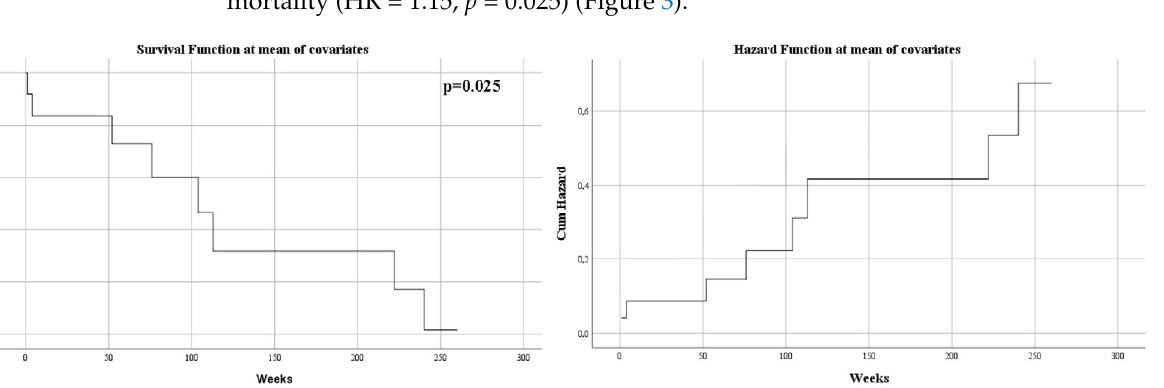
Figure 3. Univariate Cox regression analysis that expresses the risk of death in midline shift.